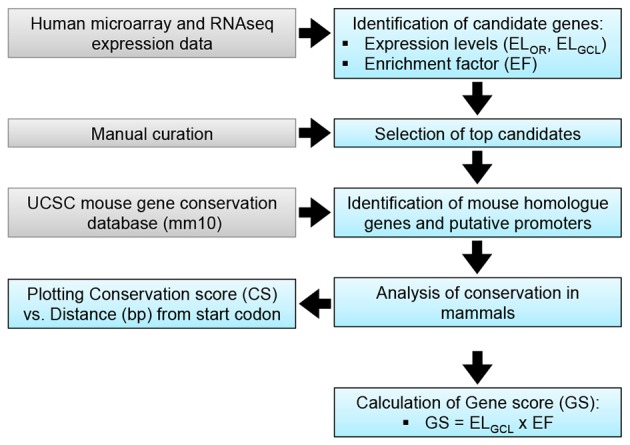
RGC promoter analysis. A: Putative promoter identification methodology. Transcriptomic data (Kim et al., 2006) was used to identify candidate genes, based on expression levels in the retina (ELOR) and the GCL (ELGCL). Enrichment factor (EF) for the GCL was calculated as EF = ELGCL/ELOR; top candidates were identified based on EF. A gene score (GS) was calculated as a means of discerning between candidates.